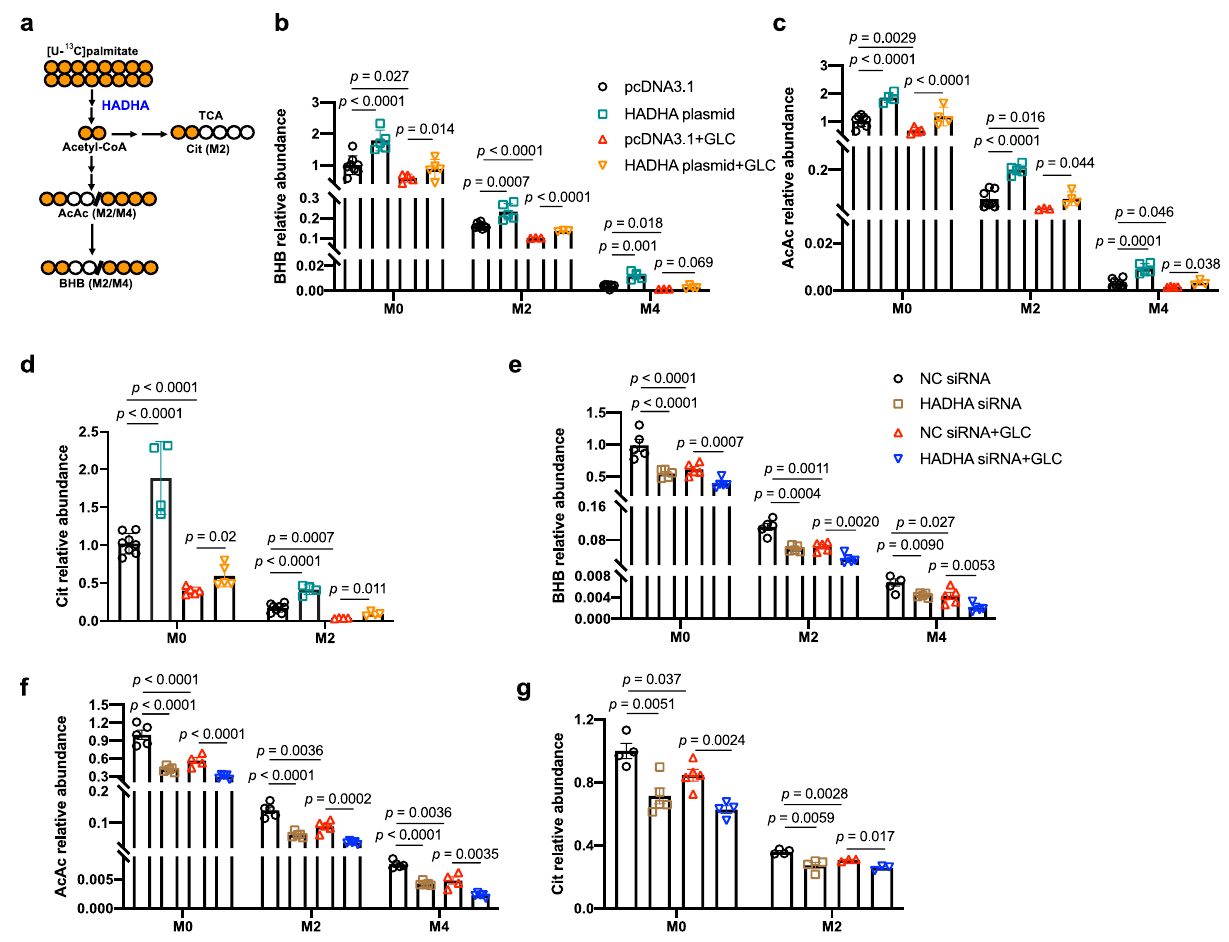
Fig. 2 Stable isotope tracing of ketogenesis. a A schematic summary of isotope tracing of ketogenesis using [U- 13 C]palmitate. b – d Primary hepatocytes treated with [U- 13 C]palmitate (0.1 mM) for 4 h followed by 100 nM glucagon stimulation for 1 h with or without HADHA plasmid transfection. b BHB relative abundance. n = 8, 5, 4, 5, 8, 5, 3, 3, 8, 4, 3, 4 (from left to right). c AcAc relative abundance. n = 8, 4, 4, 4, 8, 5, 3, 4, 8, 5, 4, 3 (from left to right). d Cit relative abundance. n = 8, 4, 5, 5, 8, 4, 4, 4 (from left to right). e – g Primary hepatocytes treated with [U- 13 C]palmitate (0.1 mM) for 4 h followed by 100 nM glucagon stimulation for 1 h with or without HADHA siRNA transfection ( n = 3 – 5). e BHB relative abundance. n = 5, 5, 5, 5, 5, 5, 5, 5, 4, 5, 5, 5 (from left to right). f AcAc relative abundance n = 5, 5, 4, 5, 5, 5, 5, 5, 5, 5, 4, 5 (from left to right). g Cit relative abundance. n = 4, 5, 5, 4, 4, 4, 3, 3 (from left to right). AcAc acetoacetate, BHB β -hydroxybutyrate, Cit citrate, GLC glucagon, TCA tricarboxylic acid cycle. Bars represent mean ± SEM values. Statistical differences were determined by one-way ANOVA. Source data are provided as a Source Data fi